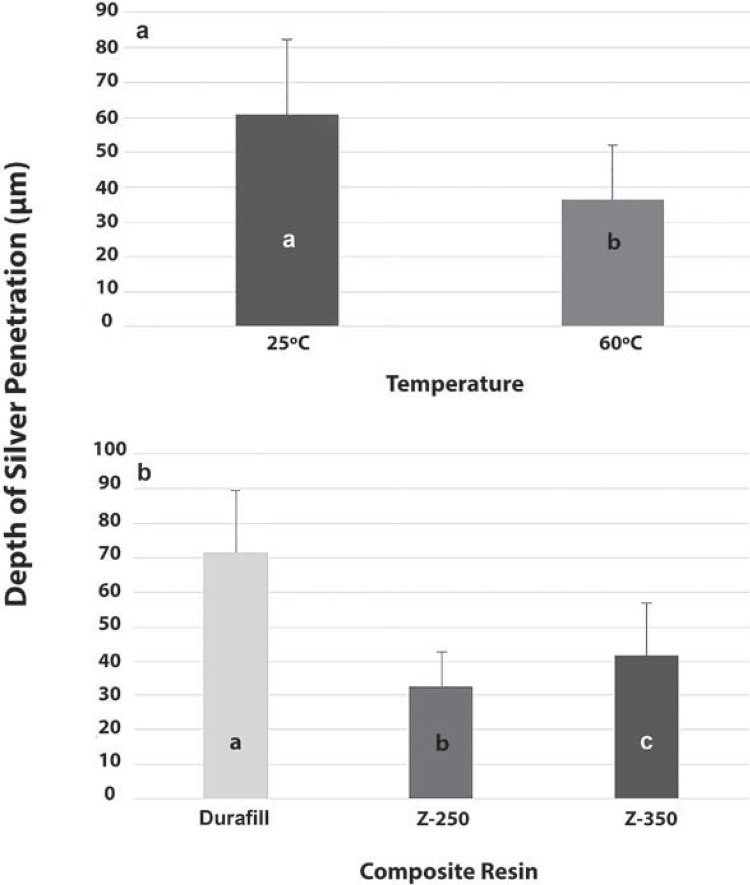
Mean values obtained for depth of silver penetration: a) according to temperature (ANOVA); and b) according to type of composite resin (Tukey’s test). Different letters indicate statistically significant differences (p<0.05)